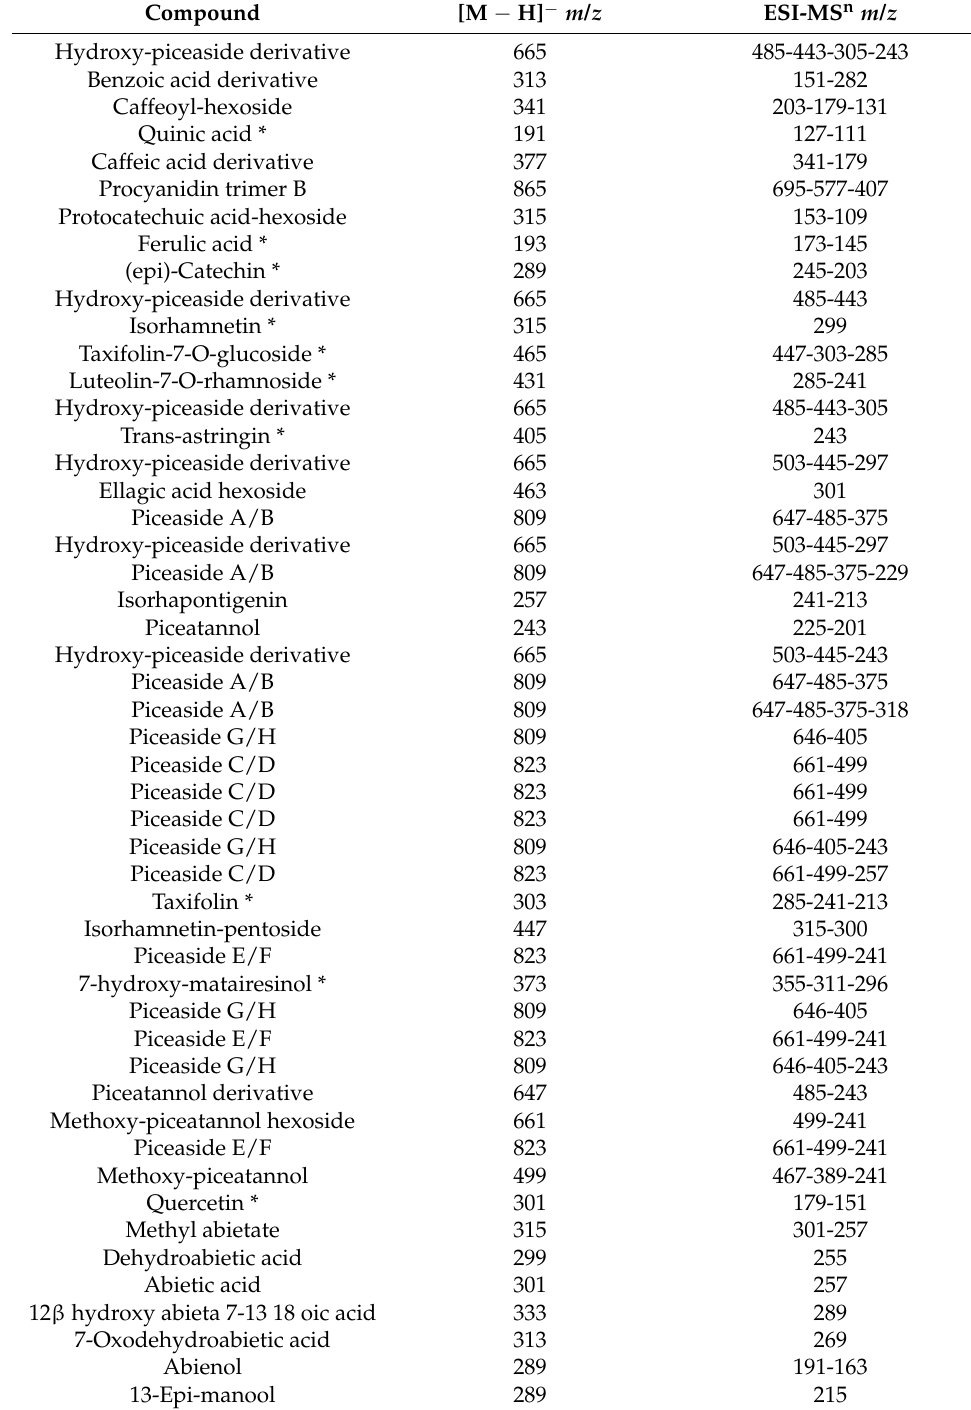
Table 3. Identified constituents of P. abies bark extracts obtained by SCO 2 , UAE, MAE, M identified by HPLC-DAD-MS n